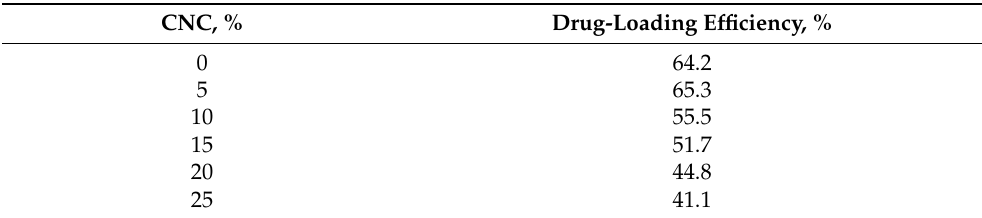
Figure 3. SEM images of the hydrogels with 5% CNC ( a ) and 15% CNC ( b ). Reprinted with permission from the authors of [94]. Copyright 2015 Elsevier. Table 2. Drug-loading efficiency of CNC-gelatin hydrogels with different amounts of CNCs. Reprinted with permission from the authors of [94]. Copyright 2015 Elsevier.